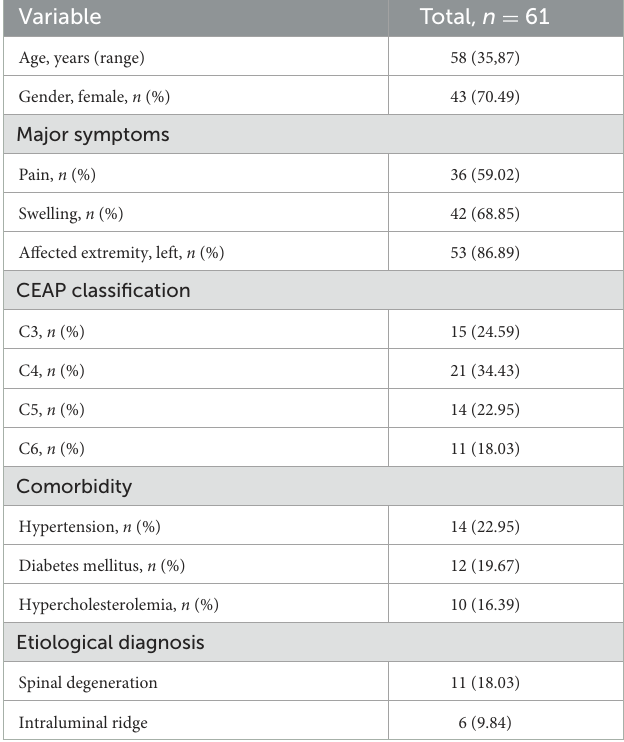
TABLE 1 Clinical features and imaging findings of non-thrombotic iliac vein